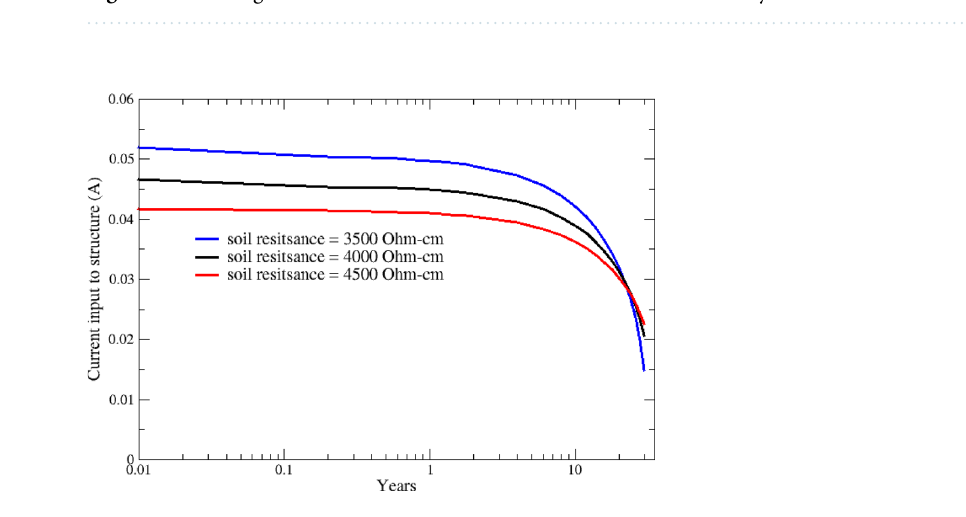
Figure 6. Discharge current from all anodes in soils with different resistivity values.